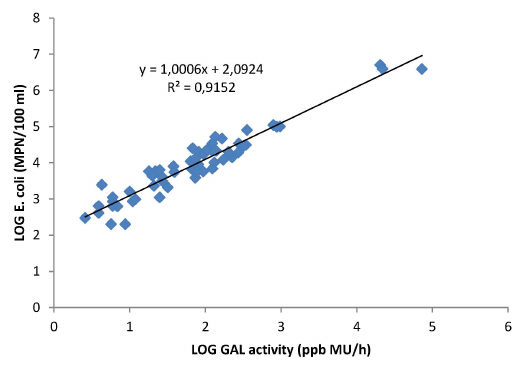
Figure 5. E. coli numbers versus GAL activity in fresh water samples ( n =